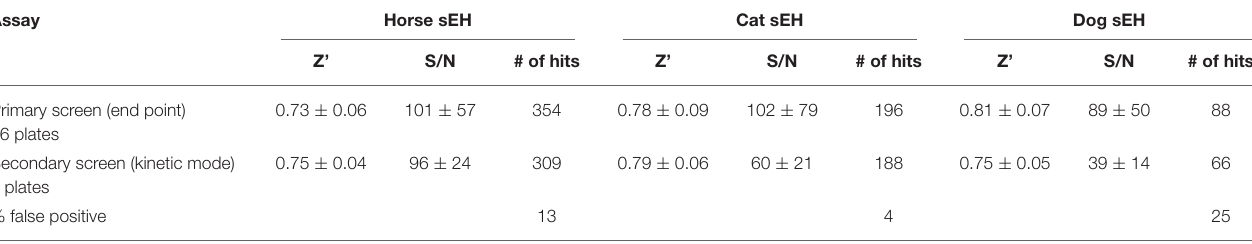
Results are average ± SD (primary screen n = 26; secondary screen n =